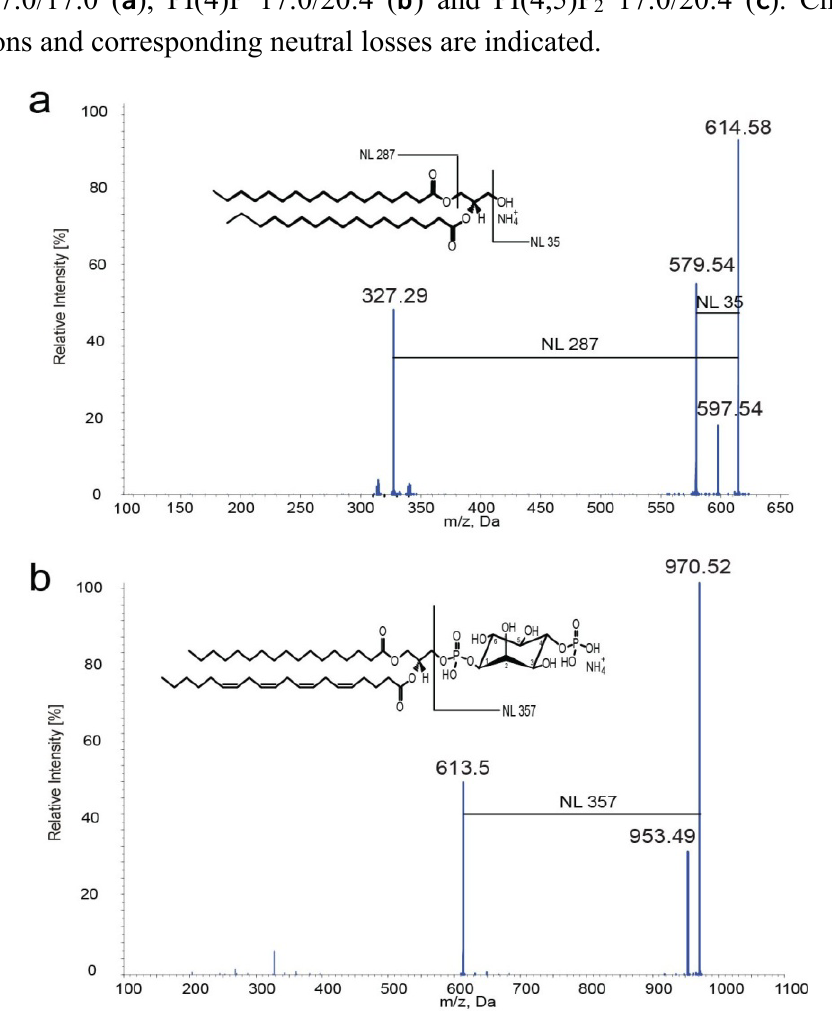
ammonium adducts. Product ion analyses 2 17:0/20:4 ( c ). Characteristic 2